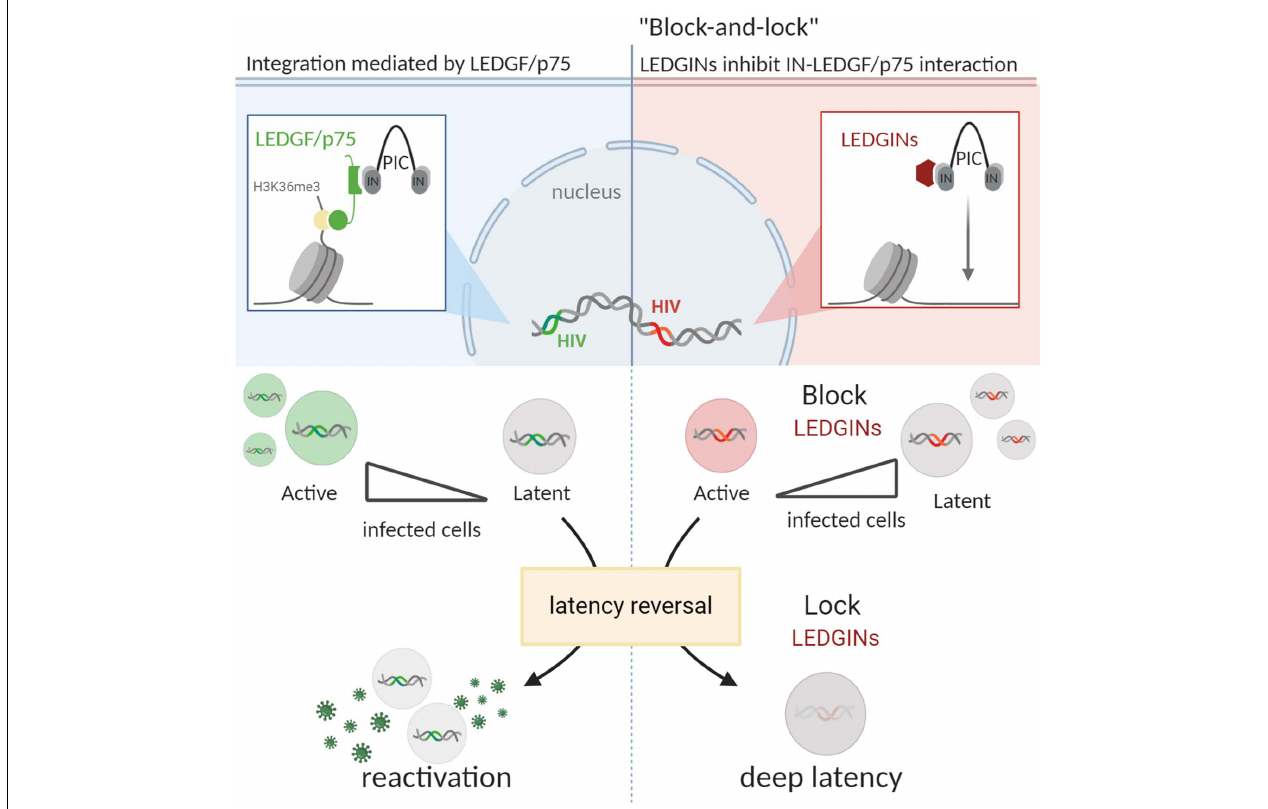
FIGURE 2 | LEDGIN-mediated retargeting provides a “block-and-lock” functional cure. LEDGF/p75 binds to the viral IN and targets the HIV-1 PIC to the chromatin via interaction with H3K36me3 (upper left part). LEDGINs inhibit the LEDGF/p75-IN interaction and retarget integration (upper right part). LEDGF/p75-independent integration in the presence of LEDGINs results in relatively more proviruses that are in a transcriptionally silent or latent state, compared to LEDGF/p75-dependent integration (middle part). After latency reversal, latently infected cells rebound, resulting in reactivation of HIV-1 gene expression (lower left part). In contrast, LEDGIN-mediated retargeting results in a cellular reservoir that is resistant to reactivation after latency reversal. LEDGIN-mediated retargeting provides a potential “block-and-lock” functional cure strategy. LEDGF/p75, lens-epithelium-derived growth factor; IN, integrase; PIC, pre-integration complex; figure created with